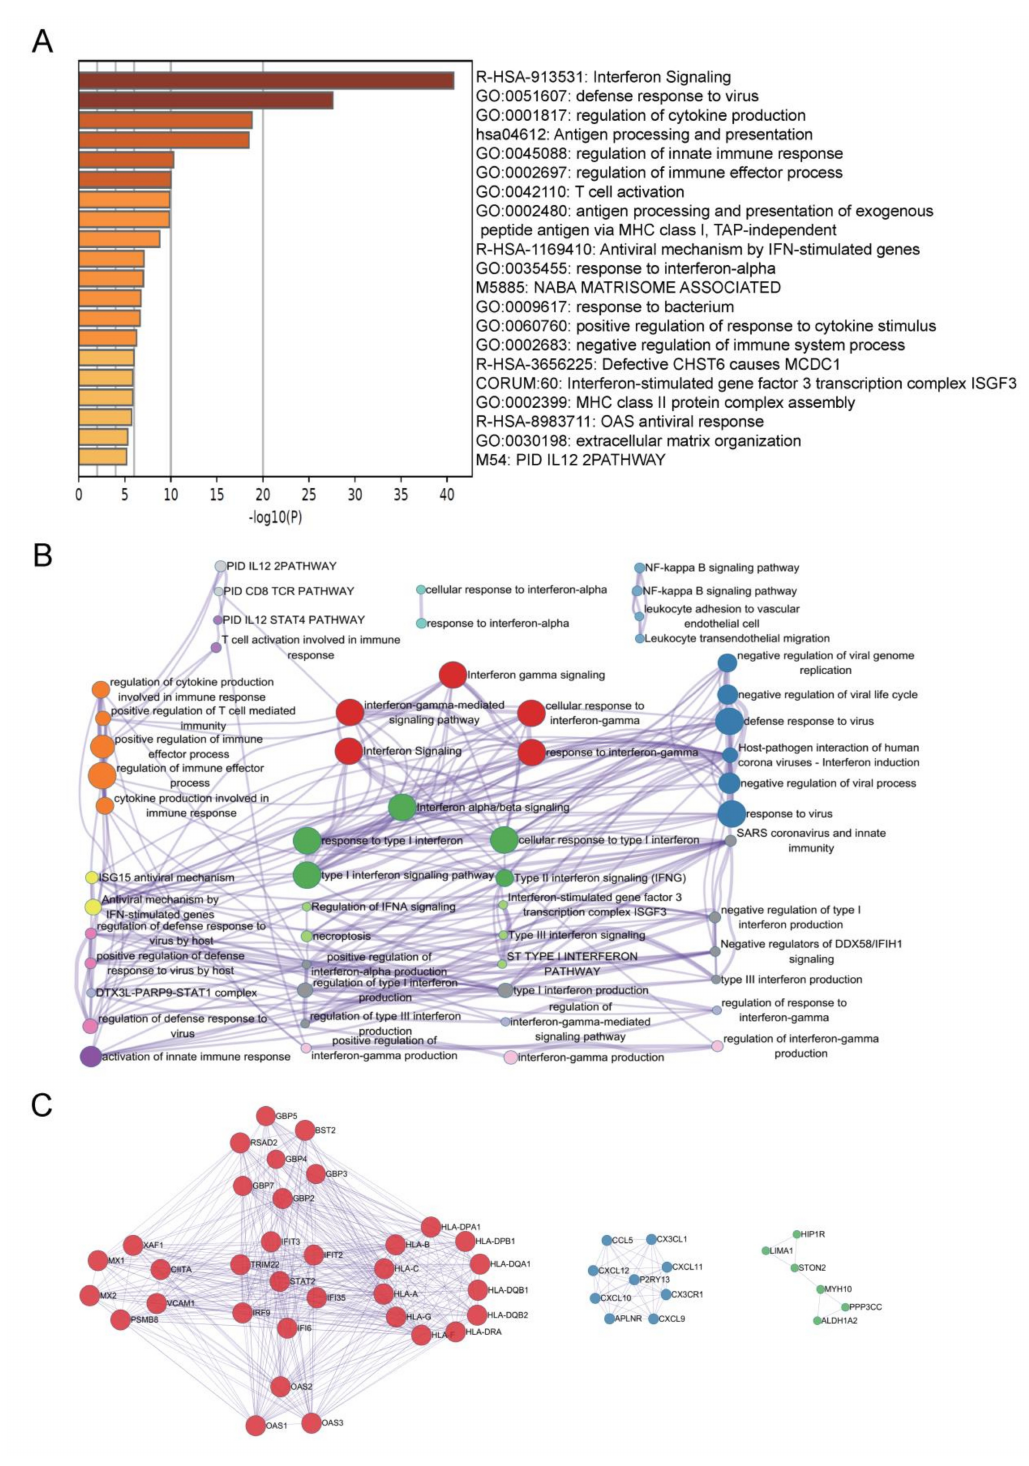
Figure 3. Function and pathway enrichment analysis. ( A ) The heatmap shows the top 20 clusters of enriched sets. ( B ) Representative Molecular Complex Detection (MCODE) network node involving by ISCM significant associated genes. ( C ) Representative MCODE network node showing the key signaling pathways involved by ISCM-associated significant genes. Metascape analysis. A network of enriched sets colored by ID. Threshold: 0.3 kappa score; similarity score > 0.3. Heatmap colored by p